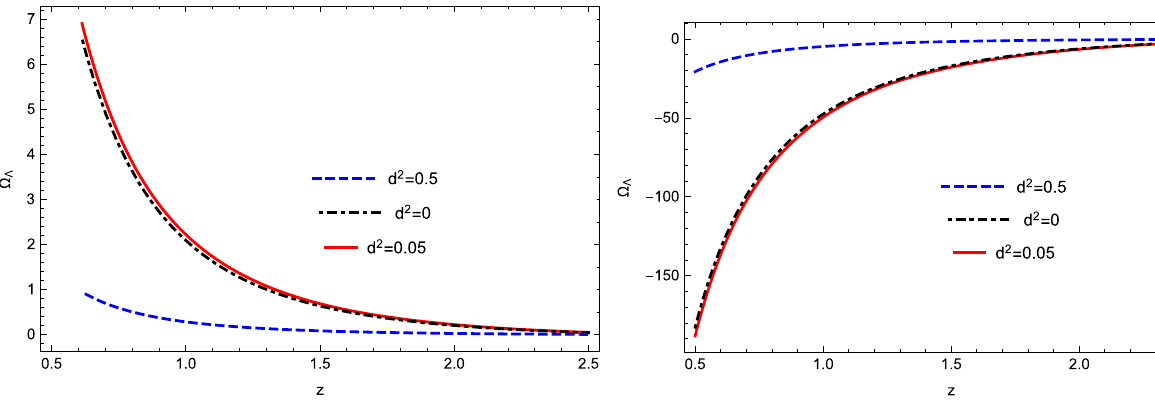
Fig. 17 Plot of (cid:9) (cid:2) verses z for u = 1 and u = 2 . 002 for Bianchi type-V model